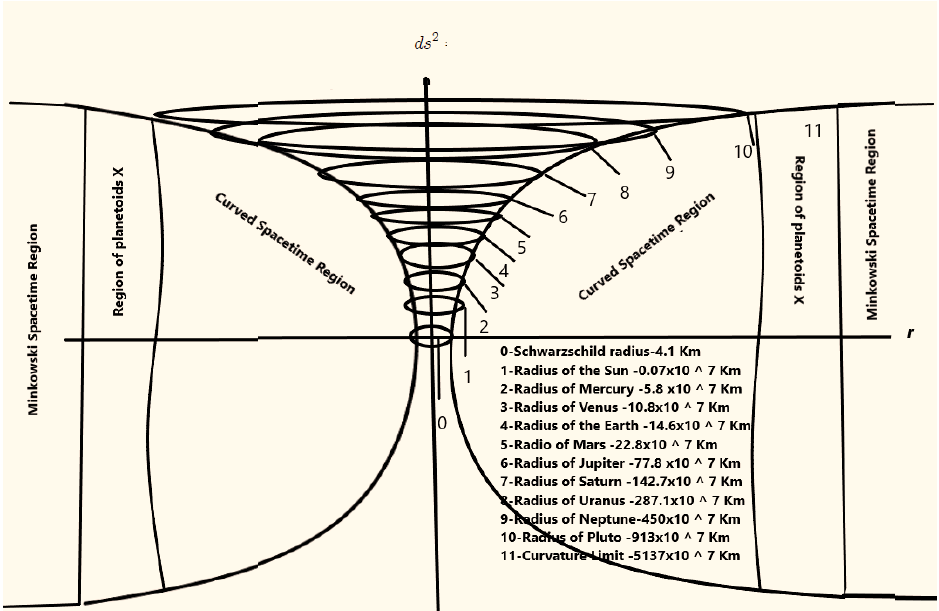
Figure 5. Schwarzschild’s cosmological model